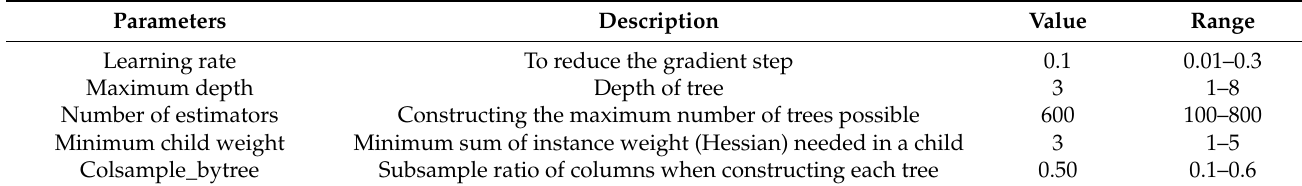
Table 2. Tuned or optimized hyperparameters of XGBoost.